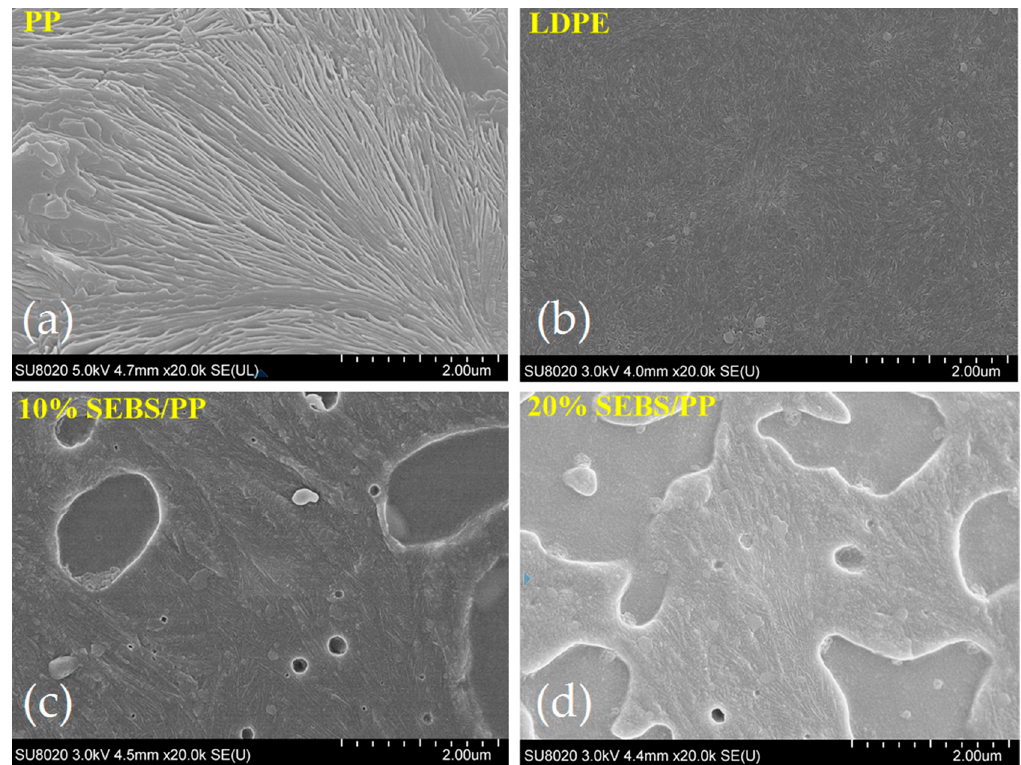
Figure 3. SEM images of lamella crystalline structures in ( a ) PP, ( b ) LDPE, ( c ) 10%SEBS/PP composite and ( d ) 10%SEBS/PP composite.